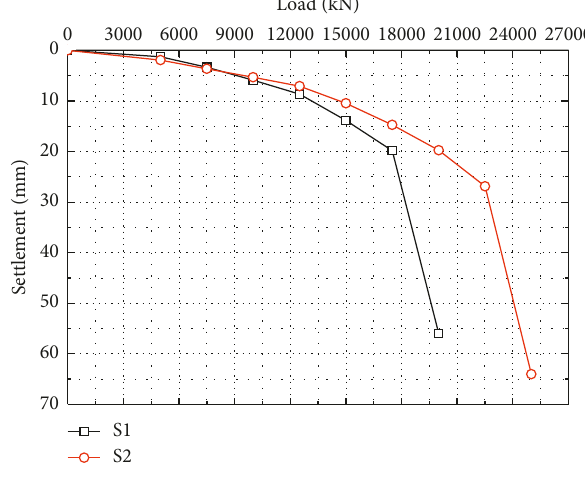
Figure 4: Load-settlement